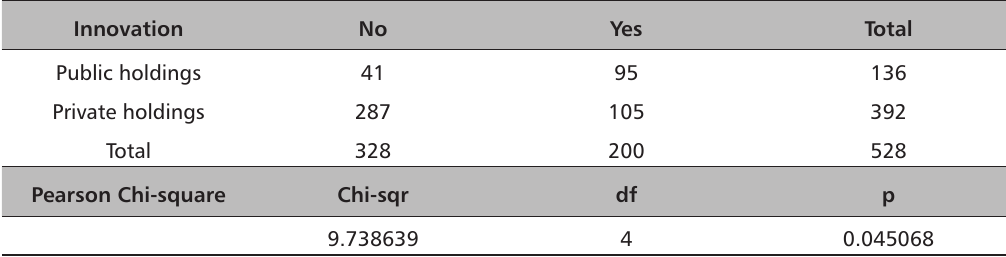
TABLE 5. Impact of forest ownership structure on innovation activity*